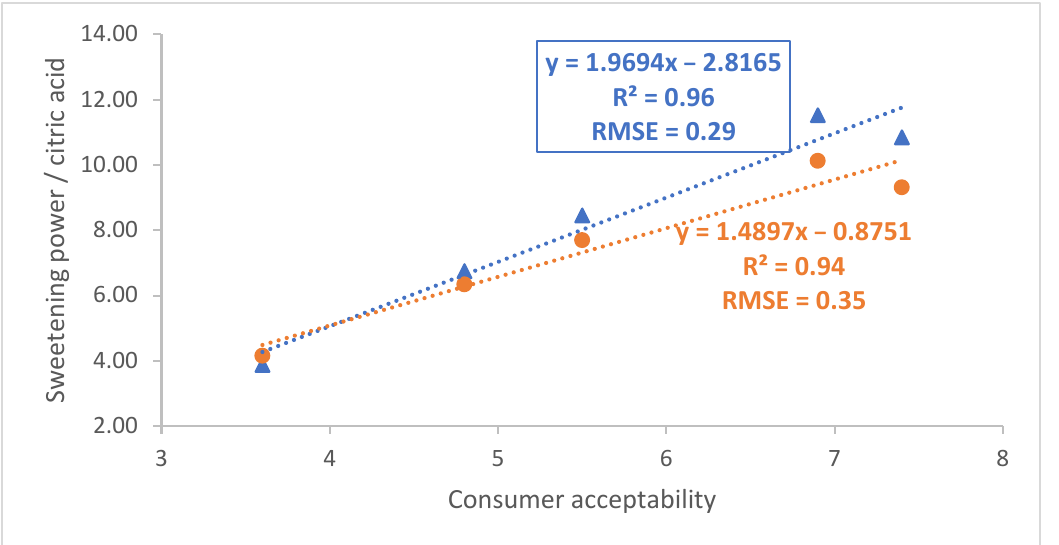
Figure 3. Correlation between consumer acceptability and sweetening power/citric acid determined using 60 and 400 MHz data (blue triangles and orange circles, respectively).